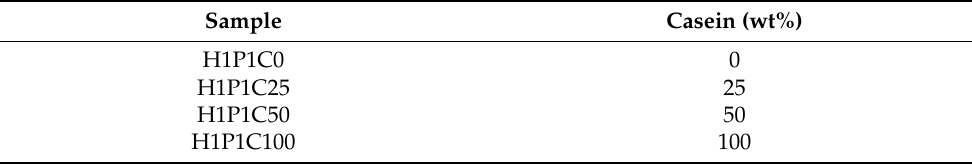
Table 1. Casein content of polymerisation